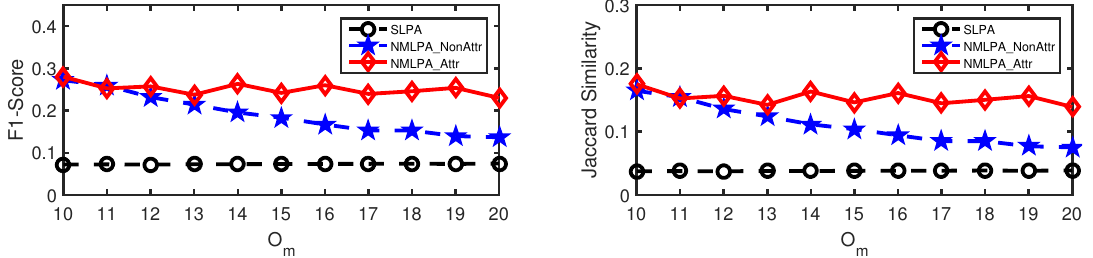
Figure 5. Performance comparison (in terms of F1-score and Jaccard Similarity, respectively) on synthetic networks with µ = 0.1.